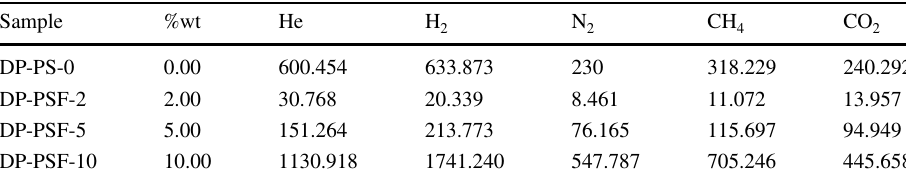
Table 12 Effect of date pit loading on permeability and selectivity (Adewole